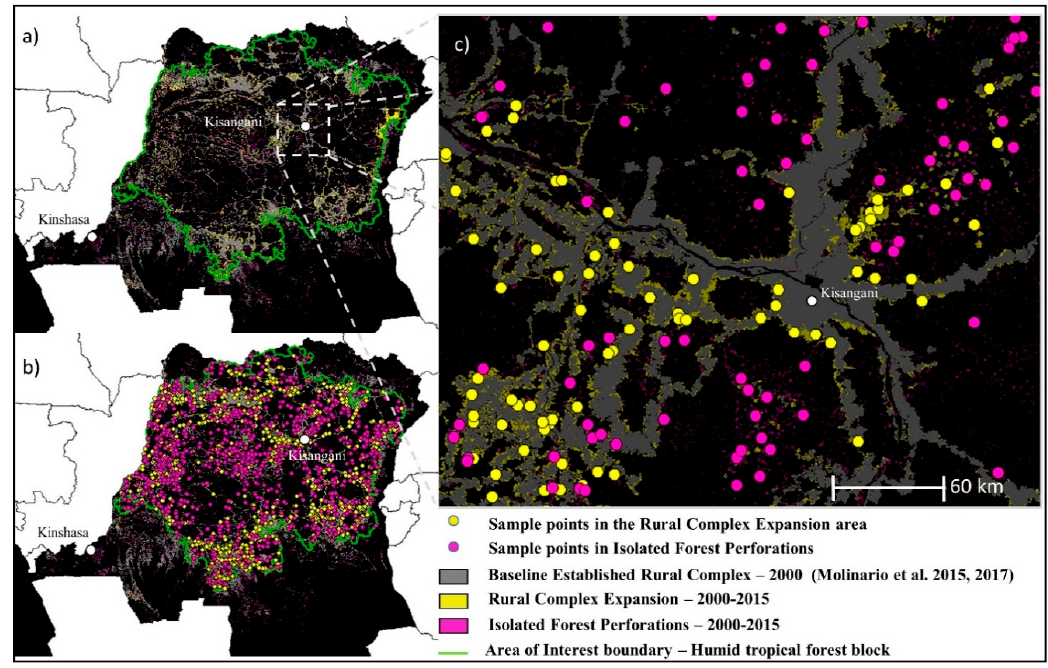
Figure 2. The DRC area is colored in black. The southernmost extension of the country is not visible. The boundaries of the humid tropical forest (our AOI) are highlighted with a green line. Only the area within this AOI was part of our analysis. The stratification at the country level is visible in ( a ), ( b ) shows the simple random sample point distribution in the RCE and IFP, and ( c ) provides a detailed picture of Kisangani that illustrates the sample distribution in the two mapped areas.